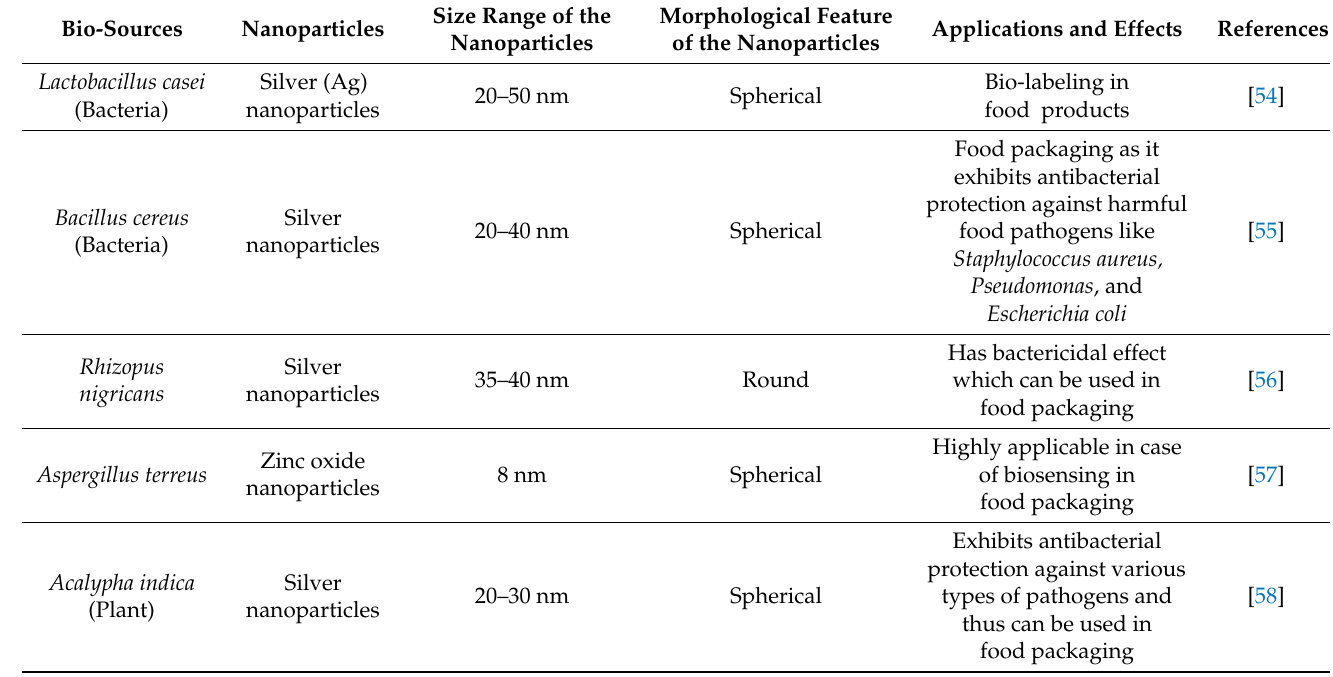
Table 1. A non-exhaustive list of nanoparticles from different bio-sources (bacteria, fungi, and plants) prepared by green technology with application in food/meat